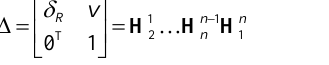
Table 1. Average closing errors for registrations with and without weight.